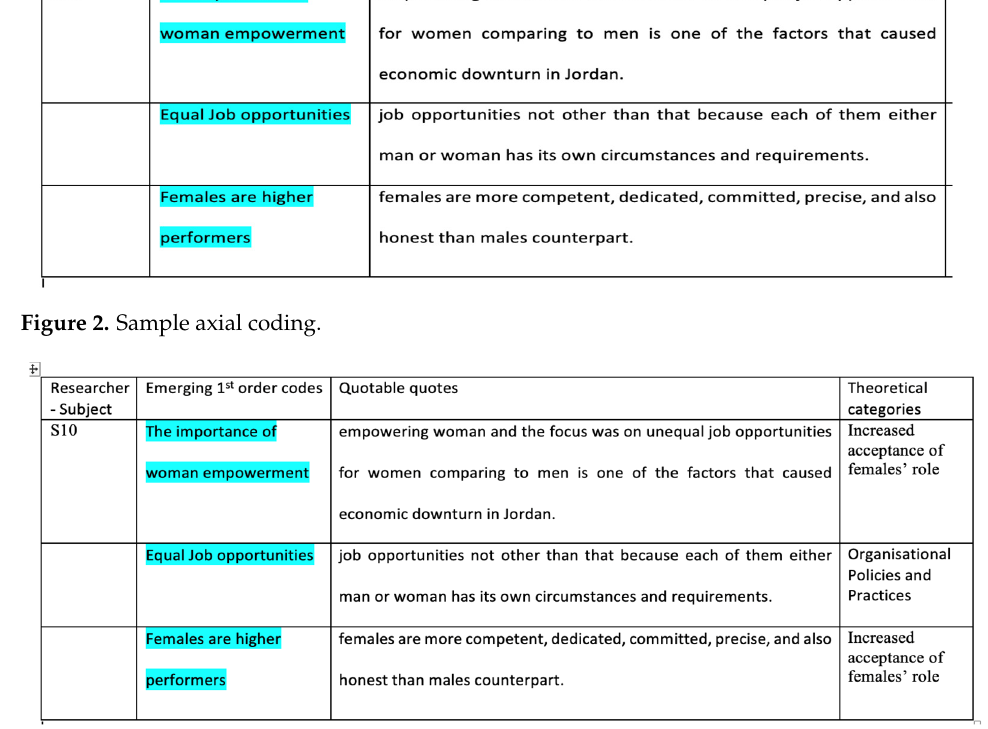
Figure 3. Sample highlighted research themes.